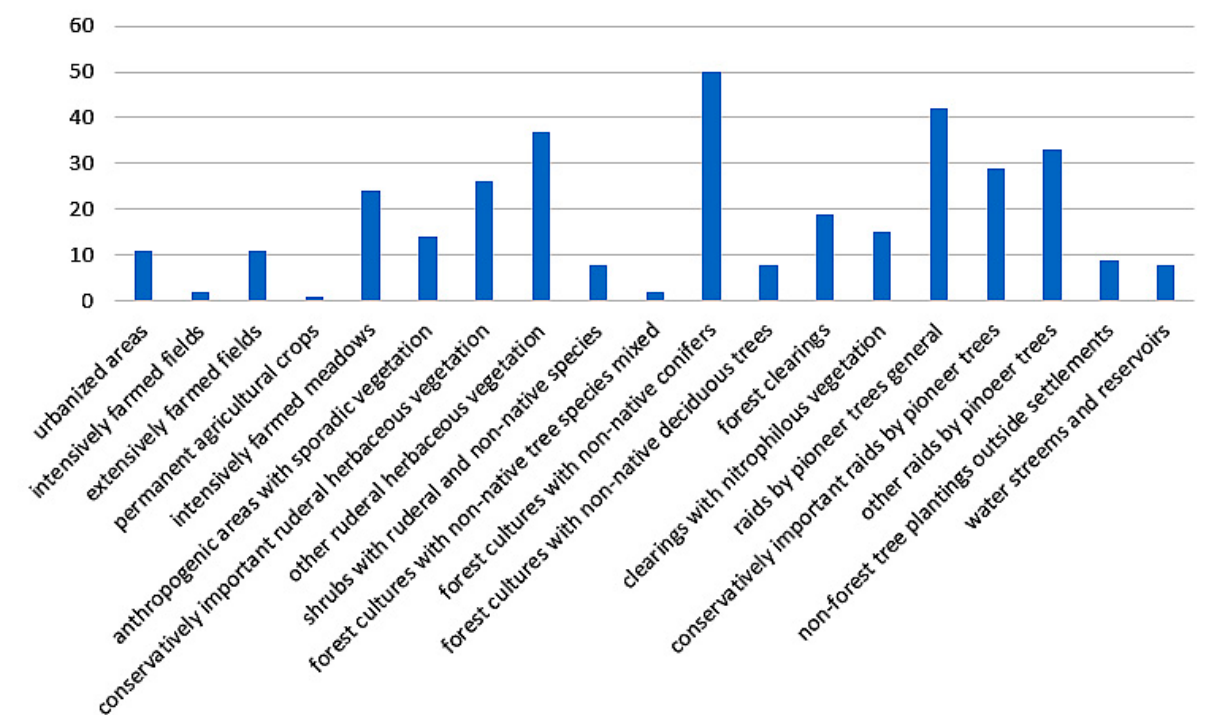
Figure 3. Numbers of extinct municipalities with representation of individual types of non-natural habitats. Source: own elaboration with use of the web portal of the information system of nature protection http://webgis.nature.cz/mapomat/ (accessed 22 January 2021).